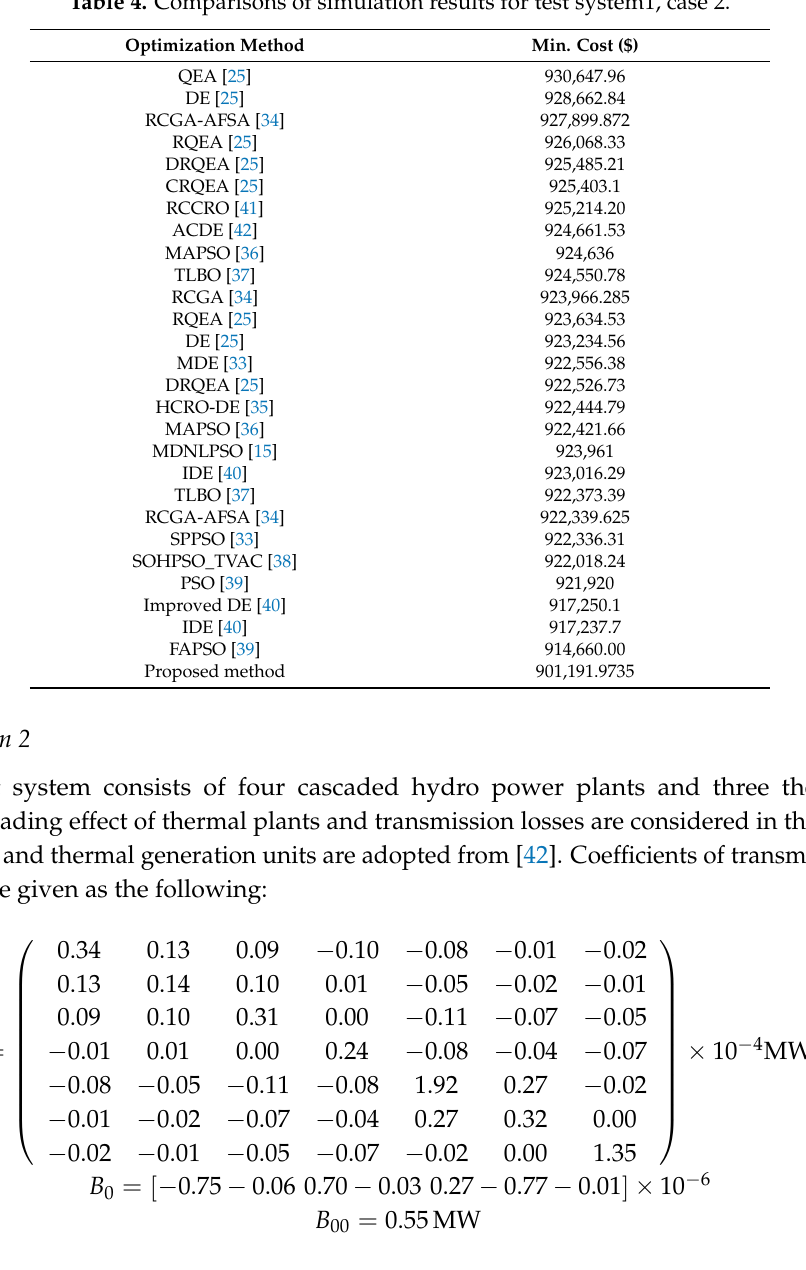
Table 4. Comparisons of simulation results for test system1, case